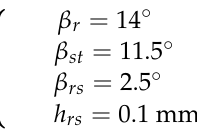
Figure 10. Torque fluctuation at different step heights for three parameter combinations. In summary, the rotor pole arc, torque pole arc, step angle, and step height of the motor were determined as